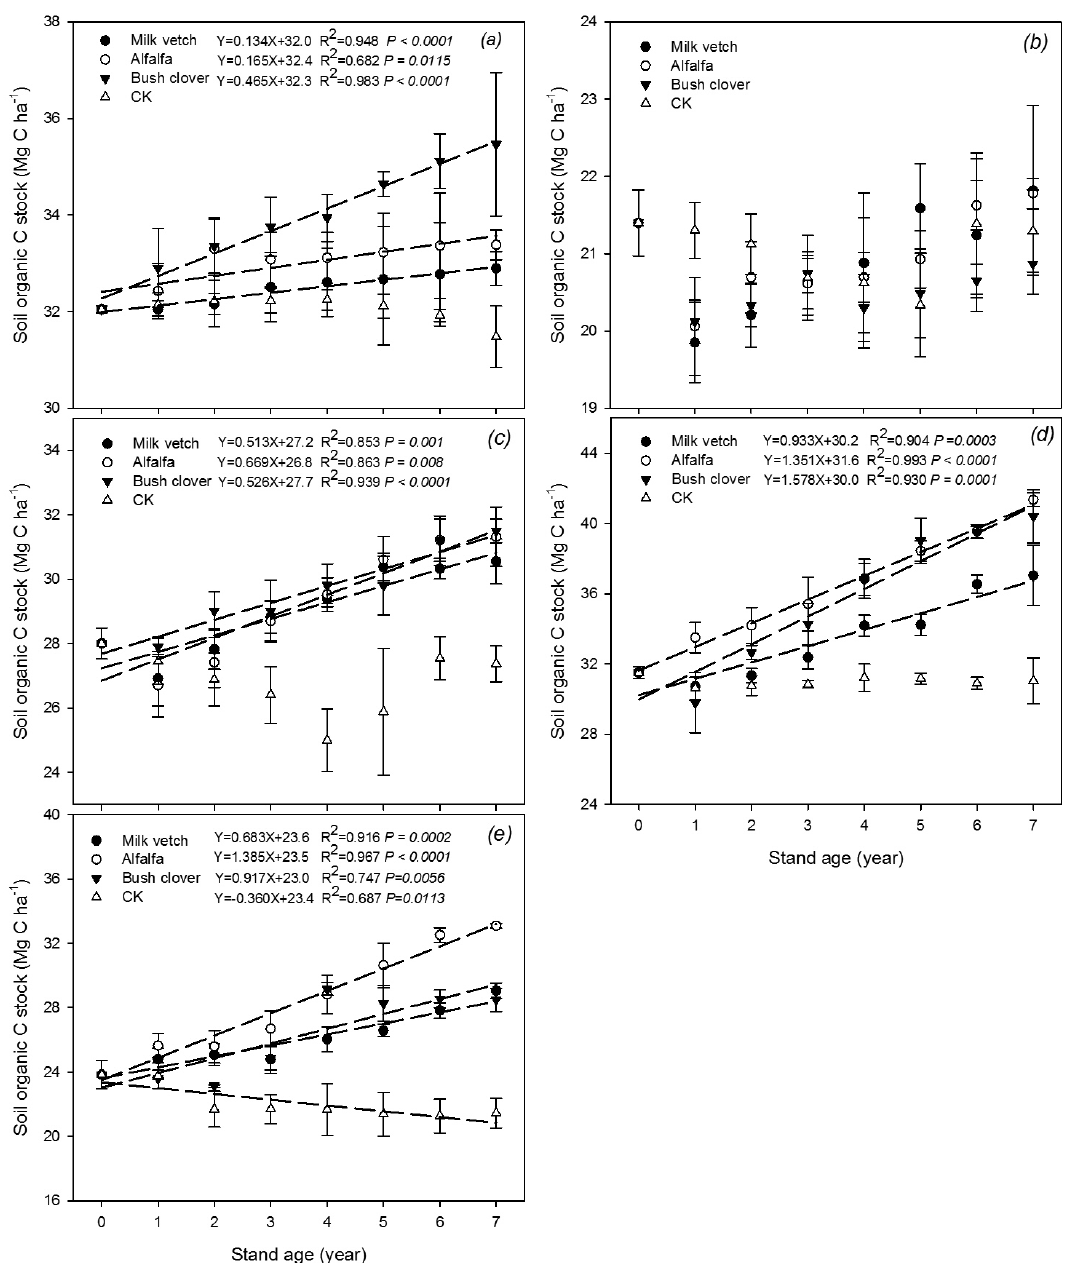
Figure 3. Change with stand age in soil organic carbon amount (stock) per hectare at soil depths of 0–0.3 (a) , 0.3–0.6 (b) , 0.6–1.0 (c) , 1.0–1.5 (d) and 1.5–2.0m (e) under milk vetch, alfalfa, bush clover and bare soil (CK). Note the soil layers vary in depth. Data are means ± one standard error of the mean ( n = 3) when larger than the symbol. Linear regressions fitted when significant and fitted regressions given.